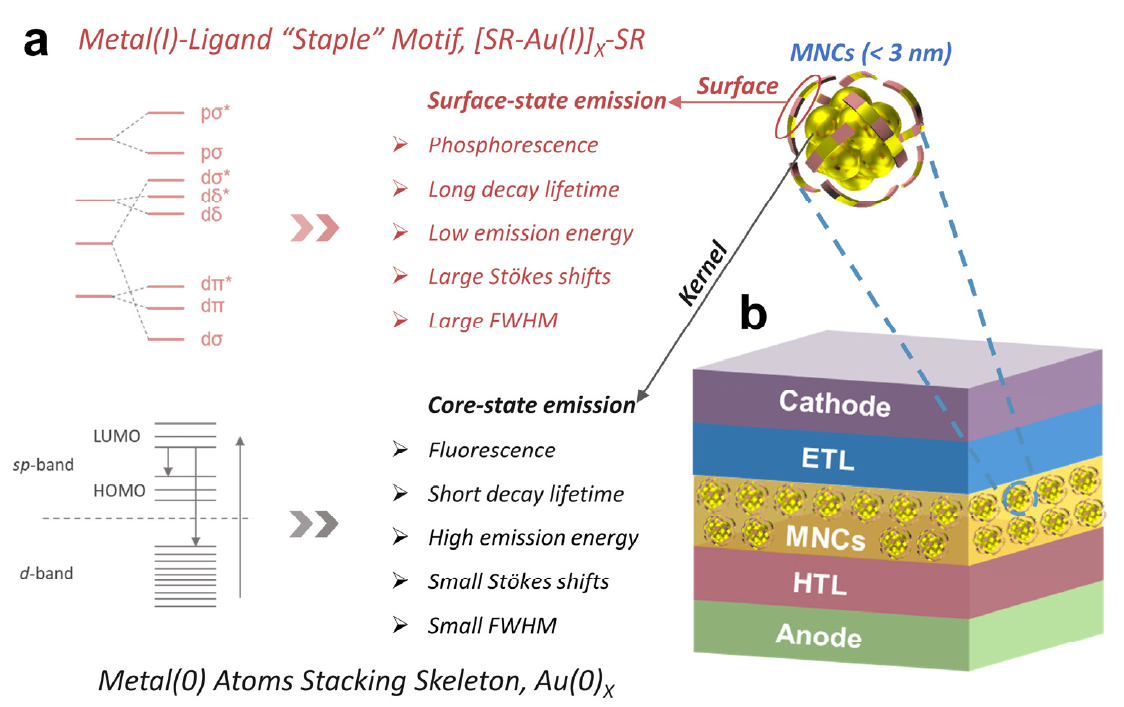
Figure 1. A simple model of MNCs and typical device structure of MNC-based electroluminescent LEDs. ( a ) The luminescence mechanism and characteristics of the surface metal-ligand motifs and kernel metal atoms correlated with the emission of MNCs. * = antibonding molecular orbital. ( b ) The general device structure diagram of conventional MNC-based electroluminescent LEDs.